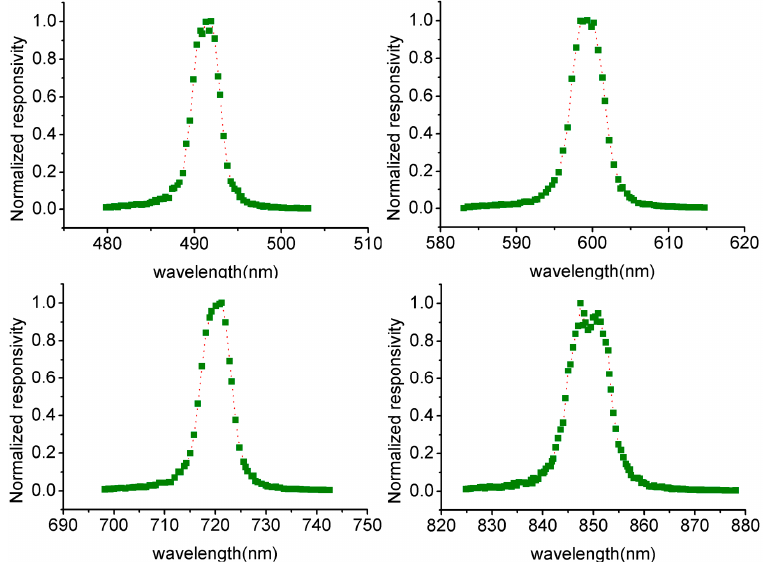
Figure 7. Spectral response of the imaging spectrometer at some bands, normalized to 1.0 maximum. The ordinate is the normalized value of the spectral response.